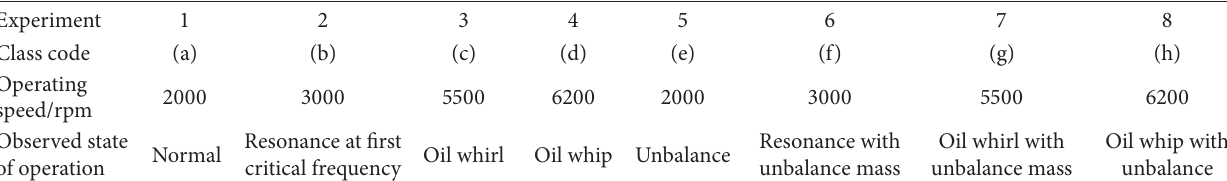
Table 1: System operation states at different operation